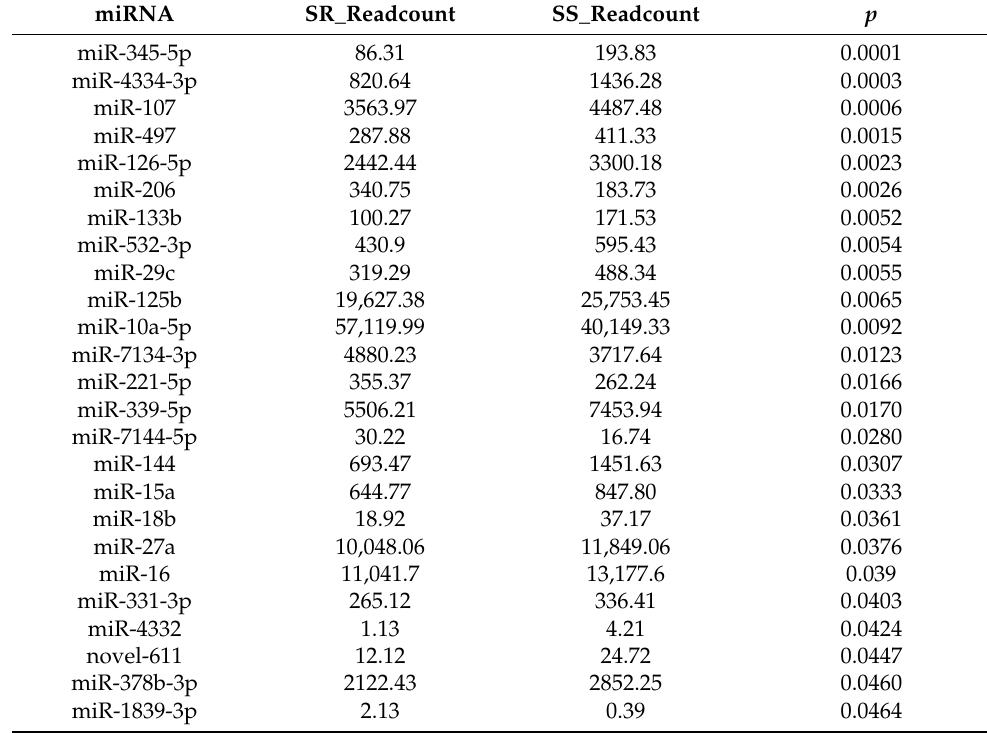
Table 4. The information of potential diarrheic resistance miRNAs.